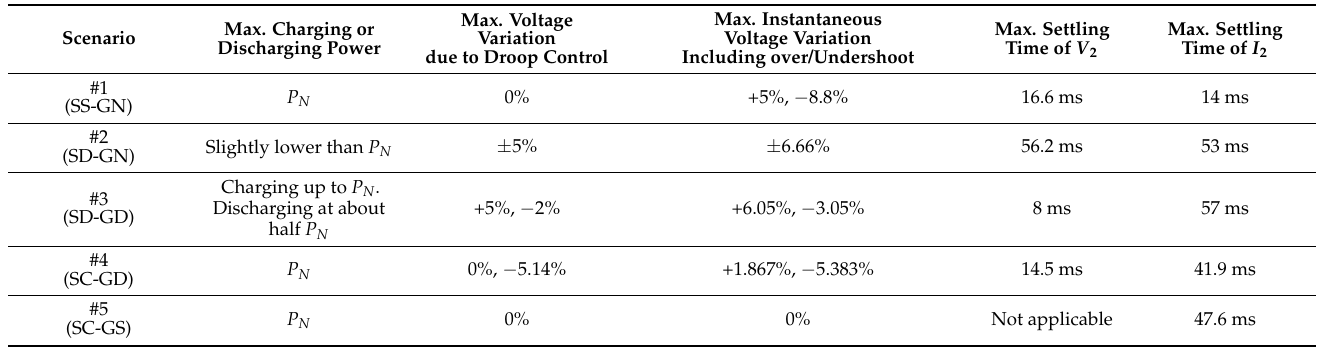
Table 6. Result comparison in the five